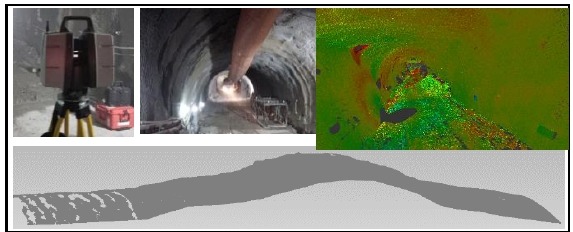
Figure 2. Experiment (top) and top surface point clouds of tunnel